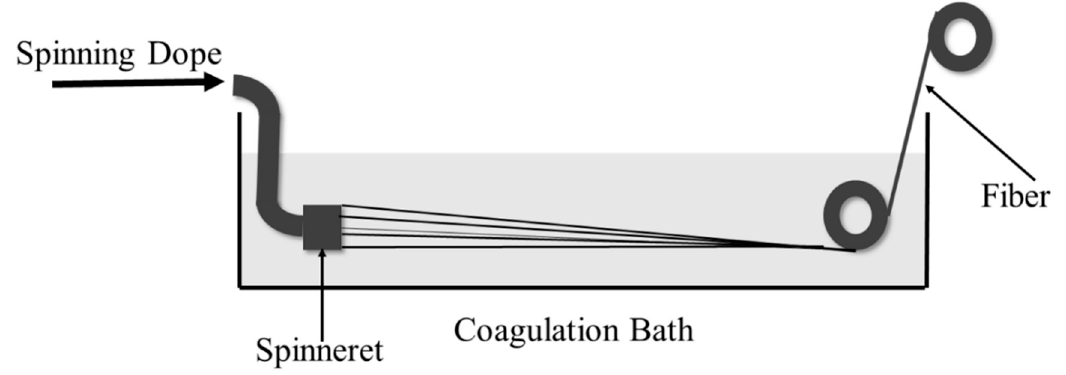
Figure 1. Schematic of the wet-spinning process for alginate fibre formation.